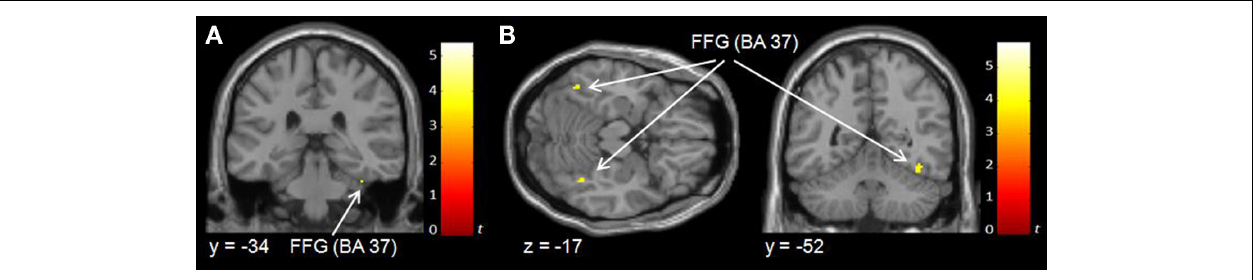
FIGURE 4 | Effects of physical change on hemodynamic activity during observation of avatar (A) and human (B)